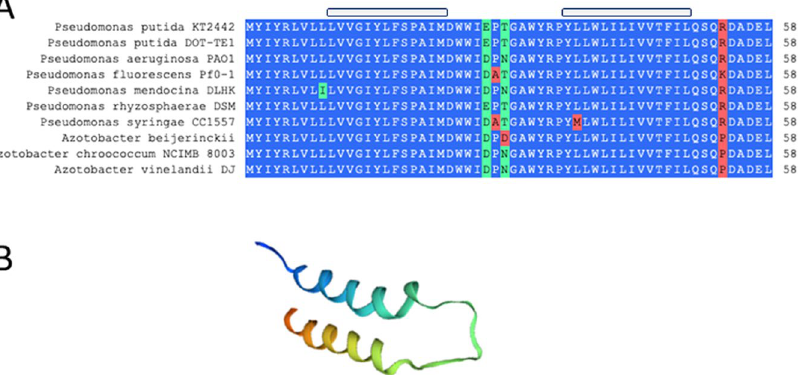
Figure 2. CbrX sequence conservation and predicted secondary structure ( A ) Sequence alignment on CbrX in different strains of the family Pseudomonadaceae . Relevant features are marked as follows: Blue aminoacids are identical, green are similar amino acids and red are non identical amino acids between strains. The span of the structural motifs shown in ( B ) are indicated on the top of the aligned sequences as a shaded box. ( B ) Predicted secondary structure of CbrX by SWISS-MODEL protein structure homology-modelling (ExPASy web